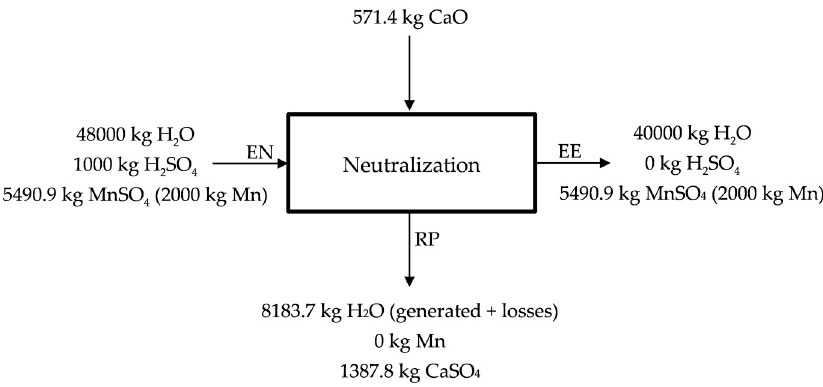
Figure 5. Description of the neutralization stage.